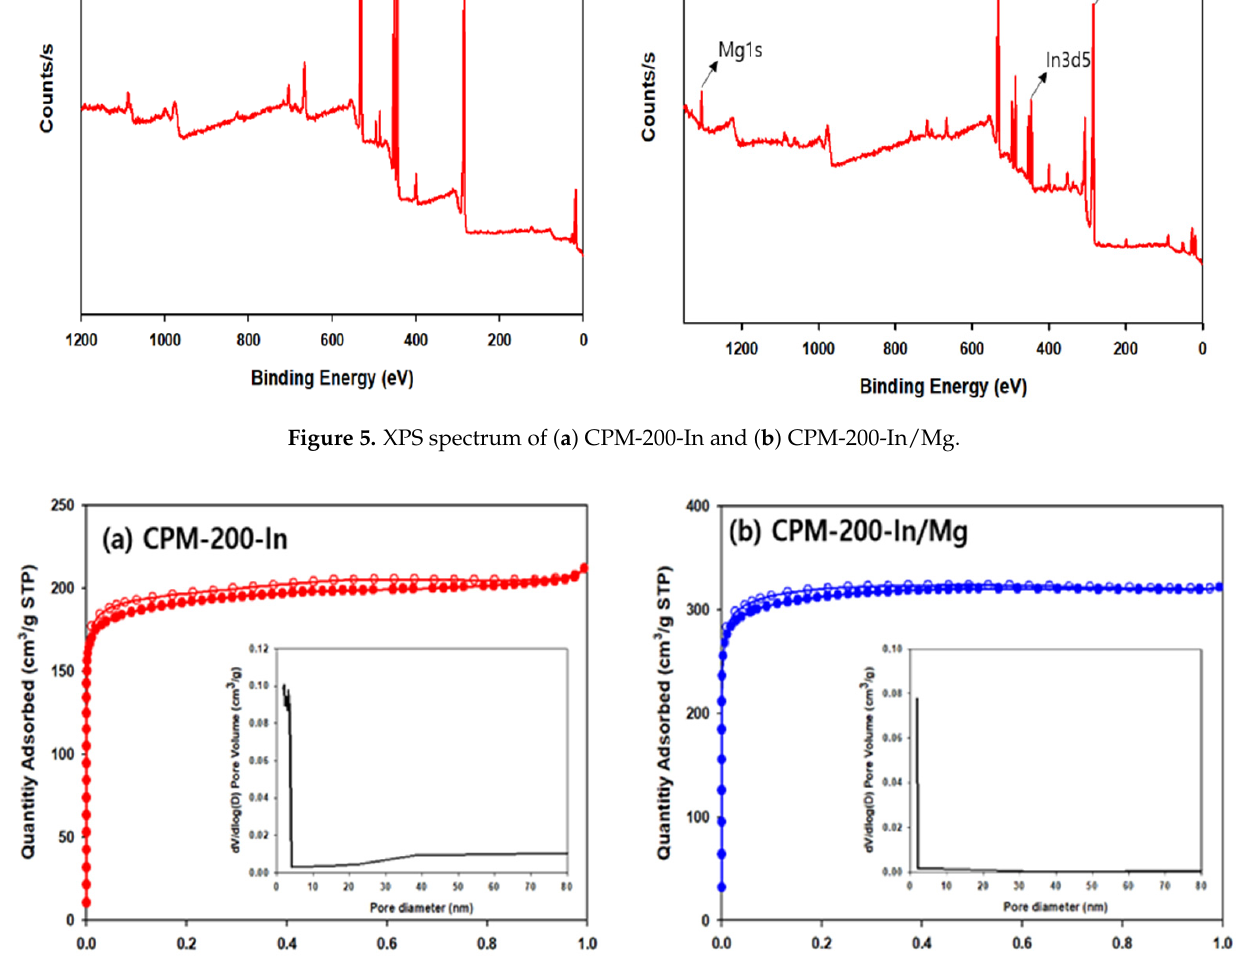
Figure 5. XPS spectrum of ( a ) CPM-200-In and ( b ) CPM-200-In/Mg.